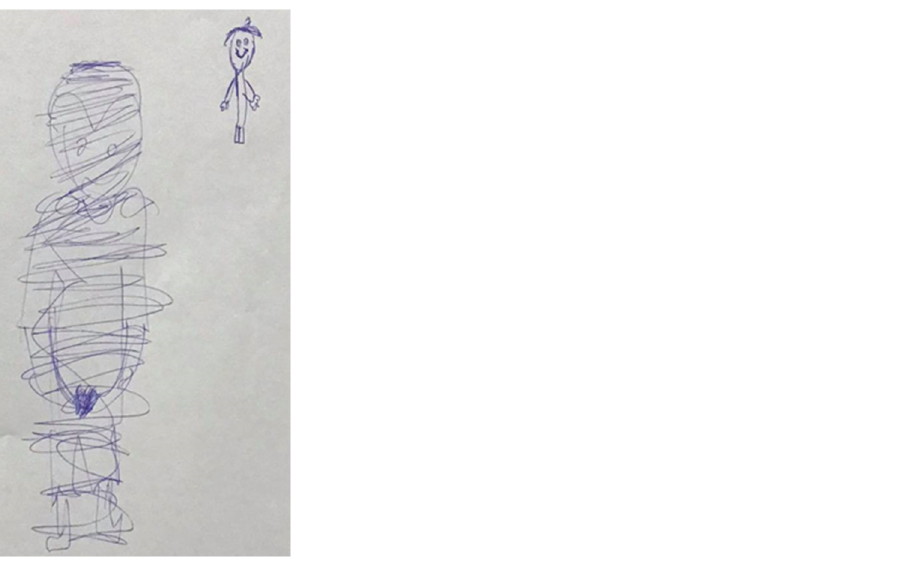
Figure 3. The drawing of a 16-year-old male participant who reported experiencing CSA. The significant drawing indicators included the presence of genitals and the emphasized face line.